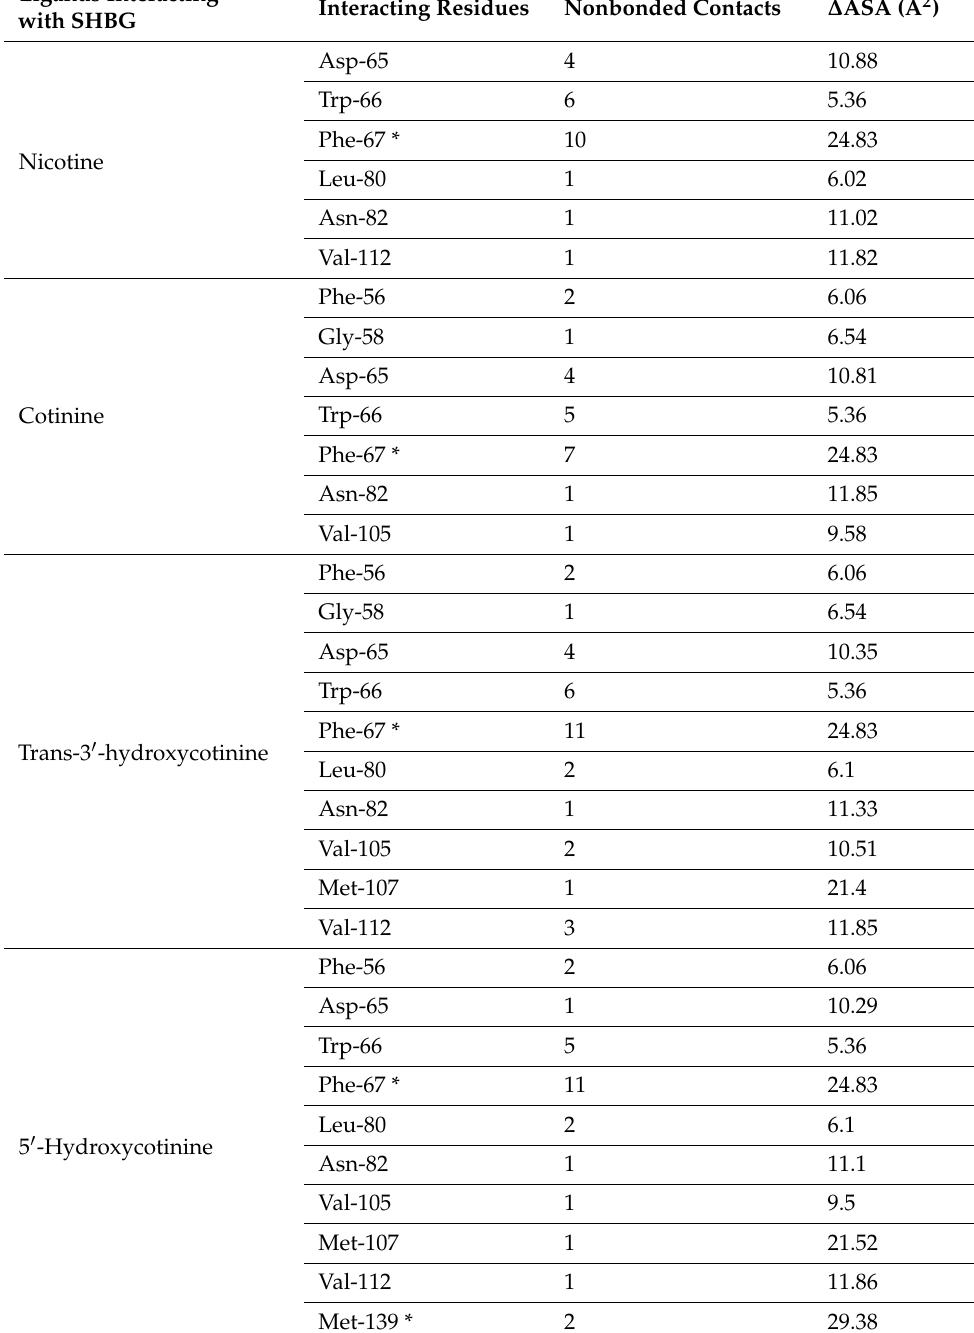
Table 3. The amino acid residues of sex-hormone-binding globulin (SHBG) interacting with nicotine and its metabolites. Each residue is listed with the number of nonbonded contacts and loss in accessible surface area ( ∆ ASA) due to ligand binding. Amino acid residues with an asterisk are the most important residues showing the maximum number of nonbonded contacts and/or the maximum loss in